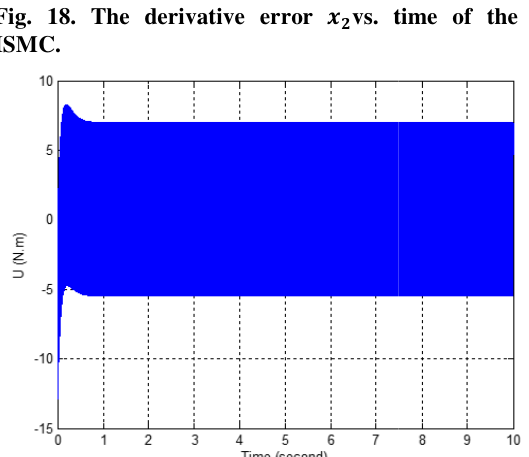
vs. time of vs. time of the b